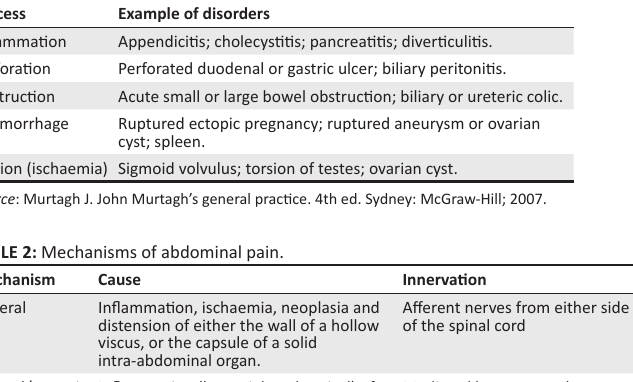
TABLE 1: Pathophysiology of abdominal pain.